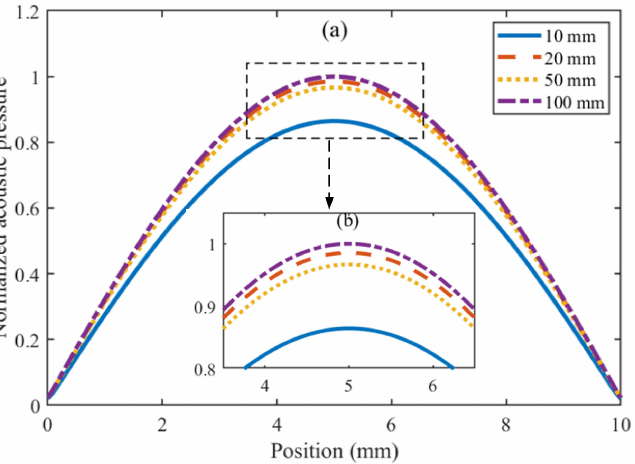
Figure 8. ( a ) Normalized acoustic pressure of the 2nd eigenmode within the photoacoustic resonator with varied bending radii; ( b ) the enlarged illustration of the central area.